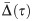
Row balance preserves chaos, and increases coherence.(A) Full coherent mode autocorrelation, Δ¯(τ) of 60 individual realizations. Thick black line shows average over realizations. Network with random connectivity J without row balance exhibits significant difference between realizations. (B) Coherent mode variance, Δ¯(0), as a function of network size for 300 individual realizations. Gray line shows average and gray region with black boundary shows one standard deviation over realizations. Without row balance the standard deviation (over realizations) saturates to a finite value as the network size increases, indicating that the variability between realizations is not a finite-size effect. (C) Without row balance a network with moderate structured connectivity (J1 = 2.5) exhibits a fixed point. (D)-(F) Same as (A)-(C) respectively, but network has “row balance” random connectivity, J˜=J-JξξTN. (D) Individual realizations of Δ(τ) are all very close to the average. (E) With row balance the standard deviation of Δ(0) over realizations shrinks with N, suggesting that the variability between realizations is a finite-size effect. (F) Same realization of J as in (C), but with row balance. Chaos is preserved. (G)-(H) Networks without row balance in blue, with row balance in red (G) Fraction of realizations (out of 30 realizations) that lead to chaotic dynamics, as a function of structural connectivity, J1. Row balance keeps nearly all realizations chaotic. (H) Coherence, χ, as a function of J1 computed for the realizations from (E). Row balance increases coherence. Error bars display standard deviation. Full line shows all realizations, dashed line displays average coherence restricted to the chaotic realizations. J1 = 0.2, g = 2, and N = 4000 for all panels unless otherwise noted.